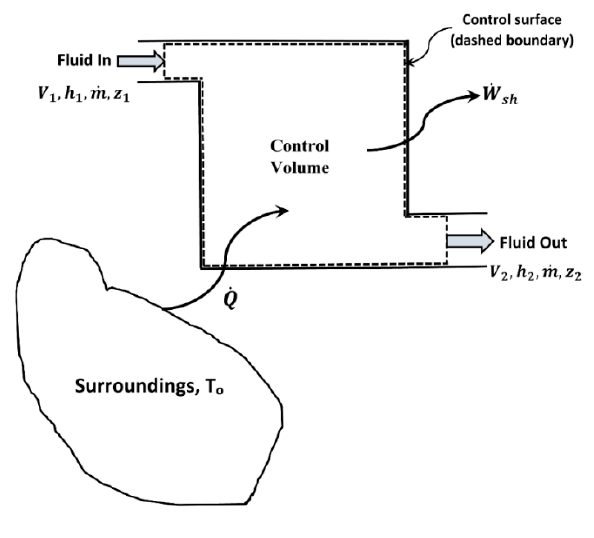
Figure 3. Typical flow process.